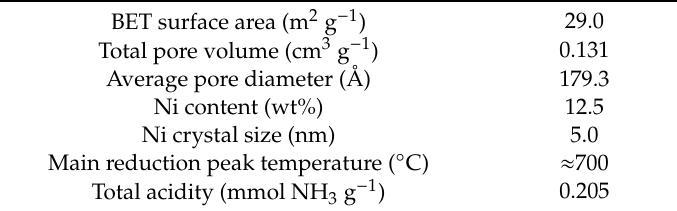
Table 3. Main properties of the catalyst used in the work (Katalco